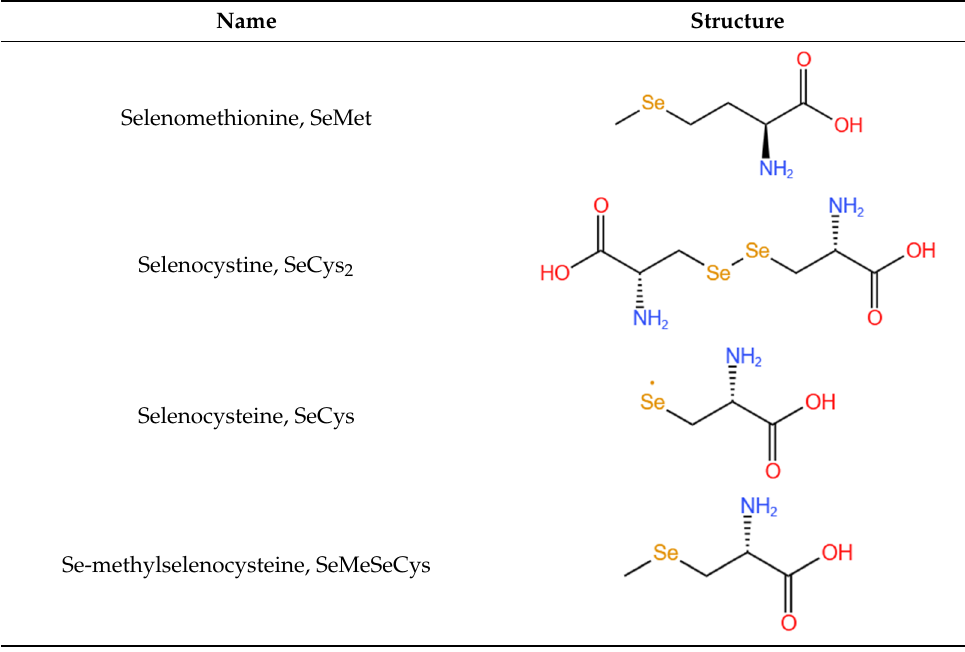
Table 2. Structural formulas of common seleno-amino acids.